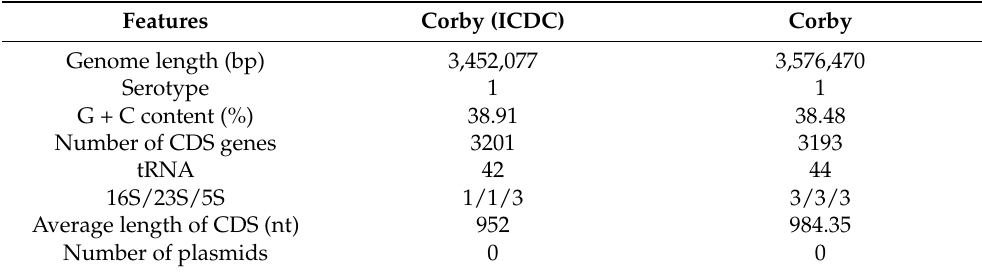
Figure 2. Genome visualization of Legionella pneumophila strain Corby (ICDC). Table 2. Main features of Legionella pneumophila strain Corby (ICDC) and Corby genomes.